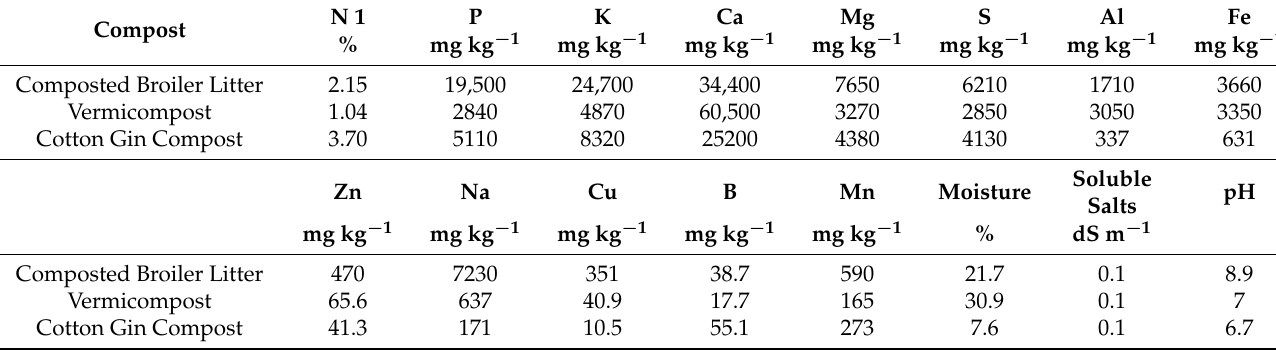
Table 1. Nutrient analysis of pre-plant composts used in a high tunnel production of zinnia “Benary’s Giant Mix”. N 1 P K Ca Mg S Compost